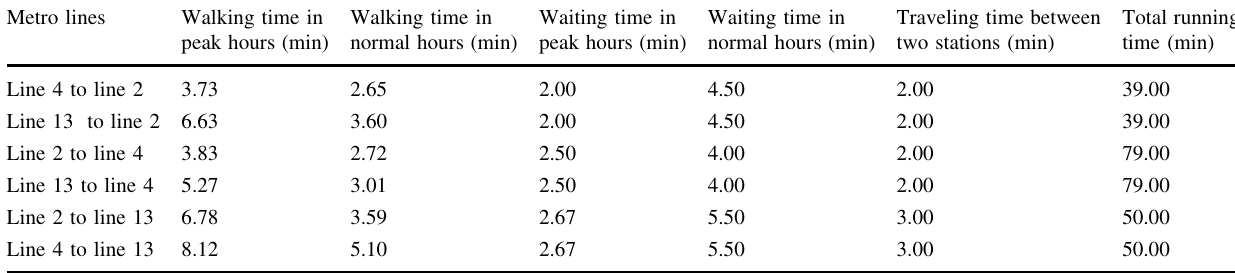
Table 5 Value of the time-associated parameters Metro lines